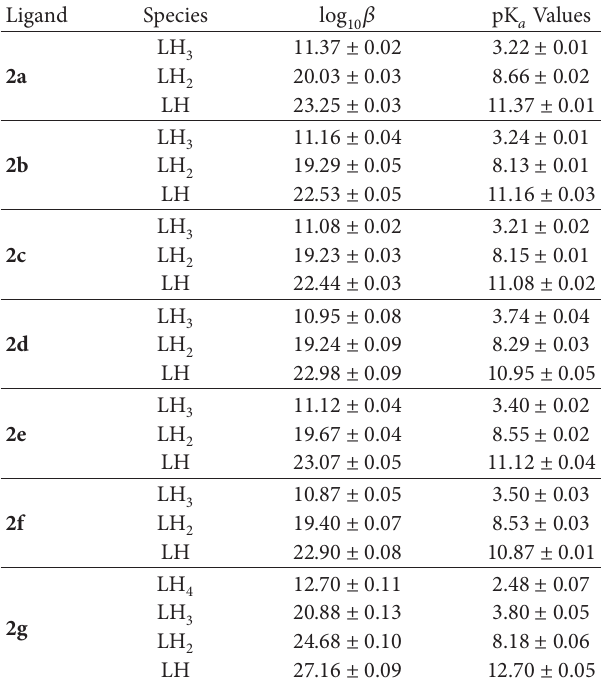
Table 1: Acid dissociation constants (pK 𝑎 ) of ligands (20% (v/v)